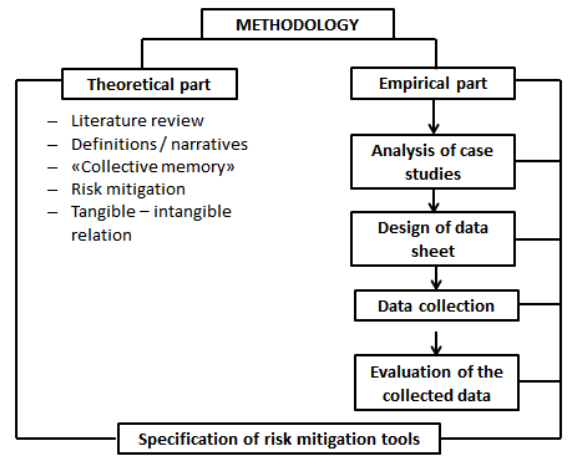
Figure 1: Steps of the